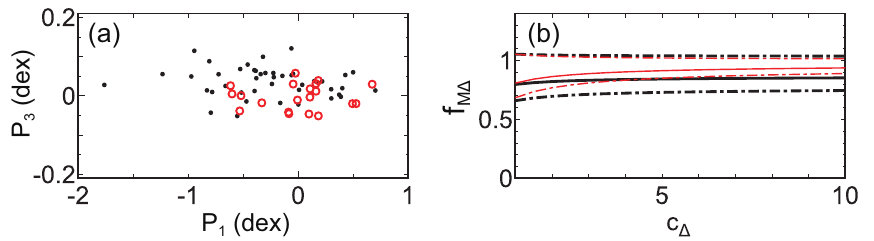
Figure 8. ( a ) Cross sections of the fundamental plane. Red open circles are the CLASH clusters (CFP) and black dots are the X-ray clusters (XFP). ( b ) Relation between f M ∆ and concentration parameter c ∆ . Solid lines are the fiducial relations and the dash-dotted lines show uncertainties. The difference of black and red lines come from the different assumptions of the plane shift (see [47]) (Figures are reconstructed from Figures 5 and 6 of